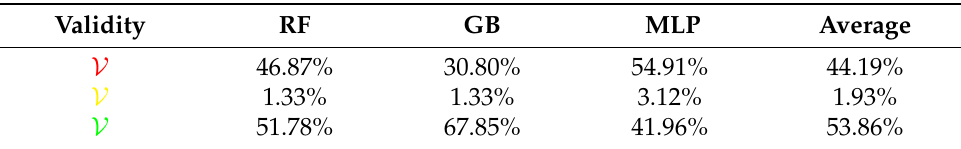
Table 11. Experiment 2: Rate of validity of RHOASo vs. HPO across all D i (% with accuracy and time complexity).